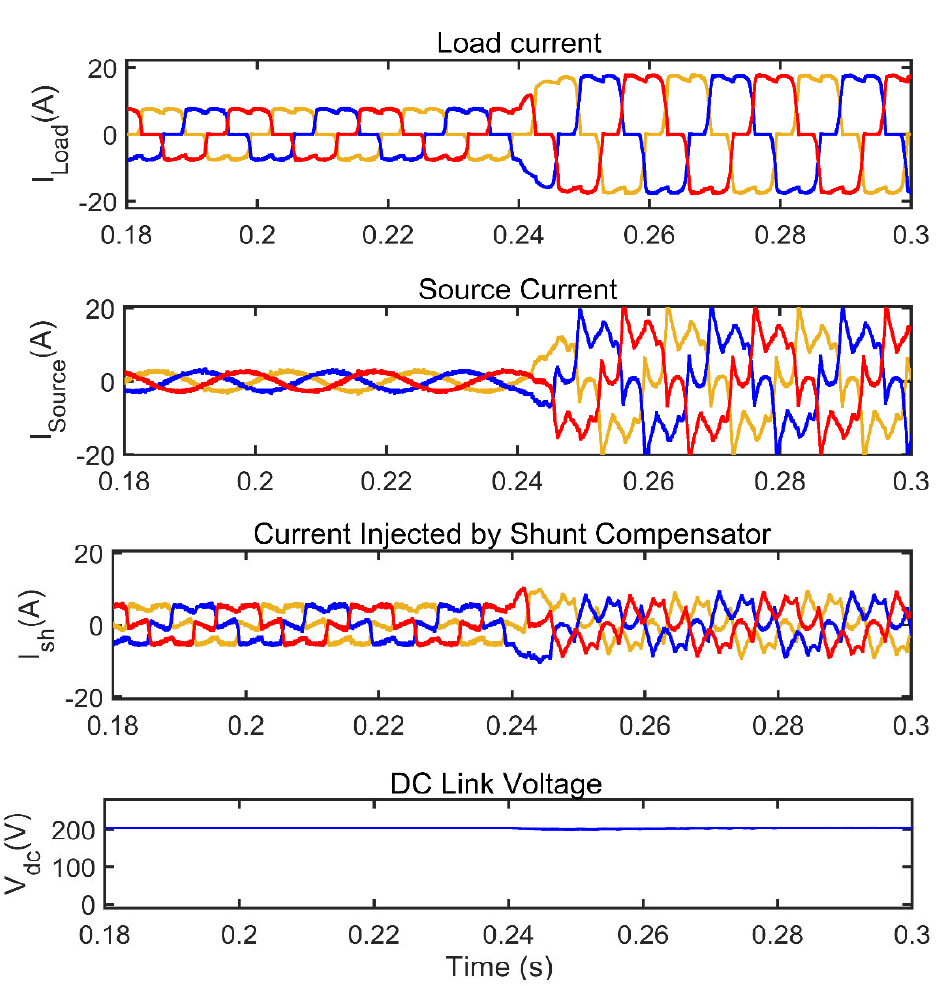
Figure 6. Performance of PV–DSTATCOM under varying load demand.